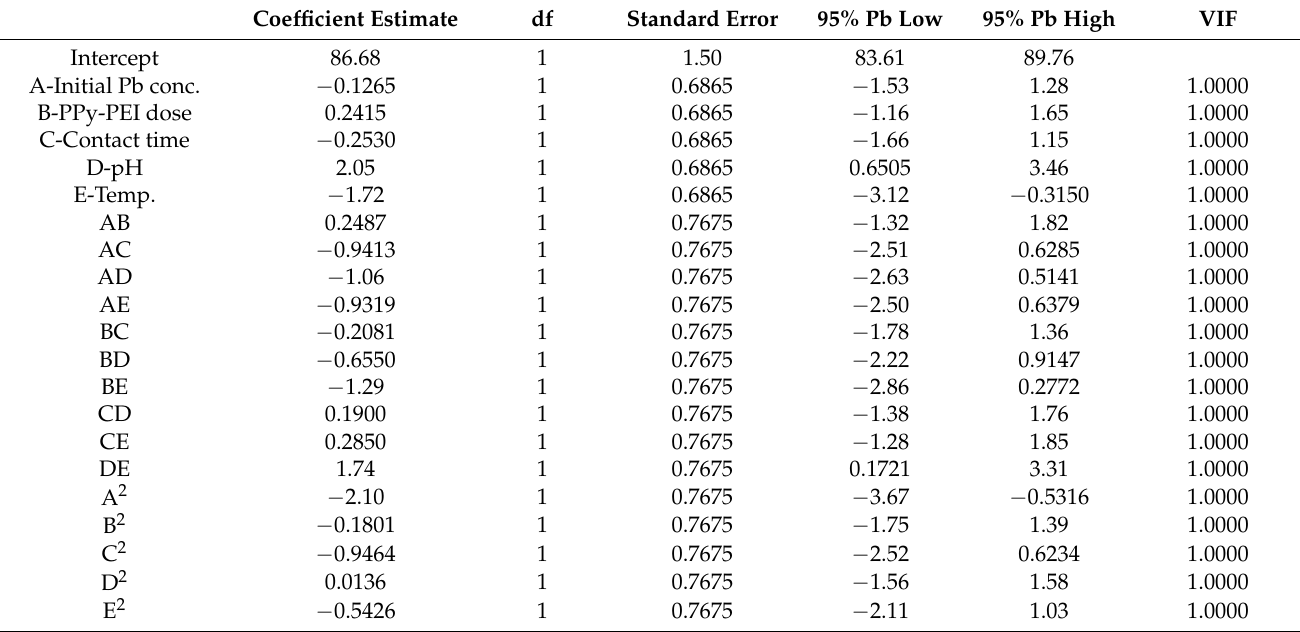
Table 5. Coefficients in Terms of Coded Factors for the responses (Pb removal).